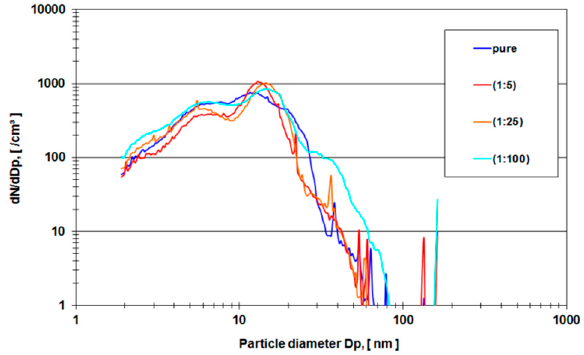
Figure 5. Calf serum without metal-on-metal articulation, digested, dilution 1:4.